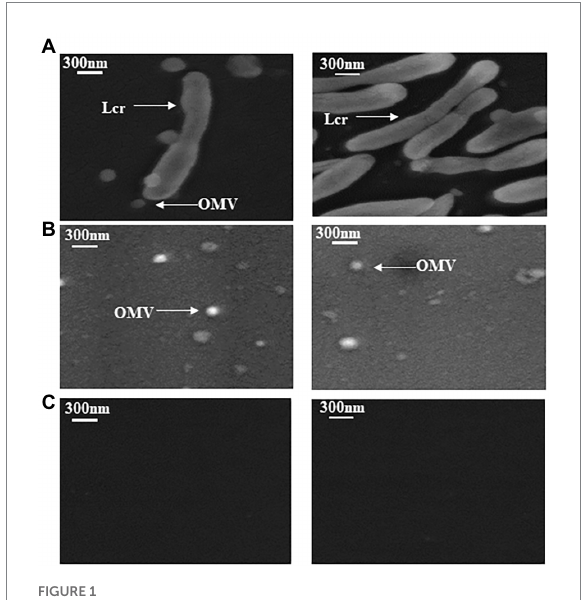
FIGURE 1 Scanning electron microscopy image of Liberibacter crescens BT-1 outer membrane vesicles. (A) Representative samples of Lcr cells. (B) Representative outer membrane vesicles (OMVs) extracted from Lcr. (C) Serum free BM7 medium. Each experiment contains three biological replicates and the experiment was repeated twice with similar